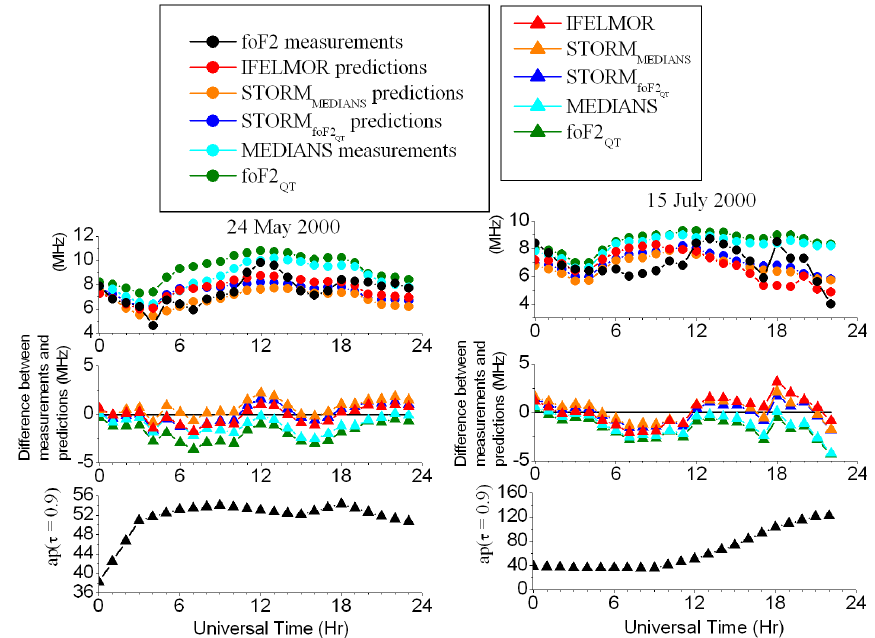
Fig. 8. Results for disturbed ionospheric conditions on 24 May and 15 July 2000. In the upper panels the black plots show the fo F2 measurements; the red plots show the predictions of fo F2 obtained with IFELMOR; the yellow plots show the predictions of fo F2 obtained with STORM MEDIANS ; the blue plots show the predictions of fo F2 obtained with STORM fo F2 QT ; the cyanic plots show the median measurements; the green plots show the hourly quiet-time values of fo F2. In the middle panels the red plots show the differences between the fo F2 measurements and the fo F2 predictions obtained with IFELMOR; the yellow plots show the differences between the fo F2 measurements and the fo F2 predictions obtained with STORM MEDIANS ; the blue plots show the differences between the fo F2 measurements and the fo F2 predictions obtained with STORM fo F2 QT . For a further comparison the differences between the fo F2 measurements and the median measurements (cyanic plots), and the differences between the fo F2 measurements and the fo F2 QT values (green plots) are also shown. Some parts of the plots do not appear because of an overlap effect. The horizontal line marks the 0MHz level (no difference observed). In the lower panels the black plots show the hourly values of the geomagnetic index a p ( τ